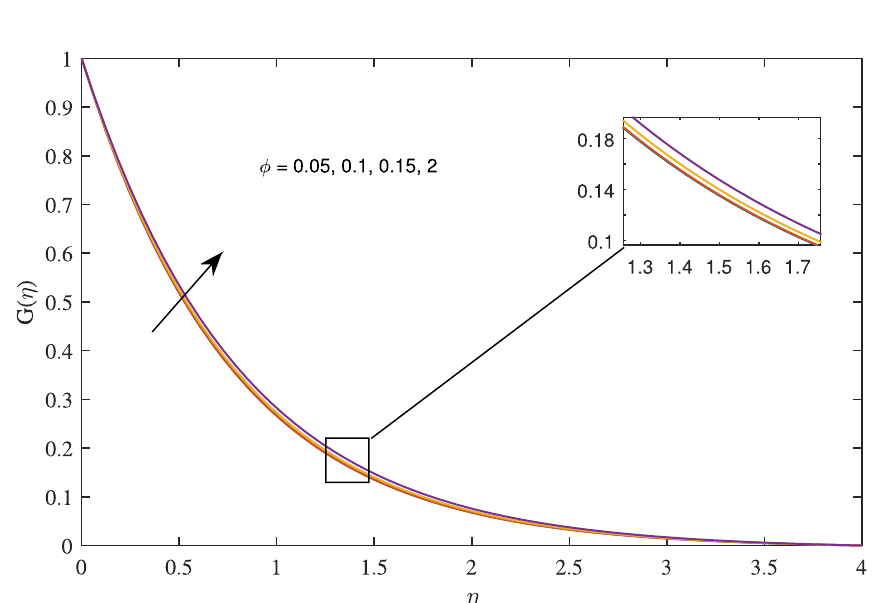
Figure 19. Effects of variation of nanoparticle volume fraction φ on radial velocity, when c 0.1 , β 0.2 N 0.2 , and Pr ζ rd = = =